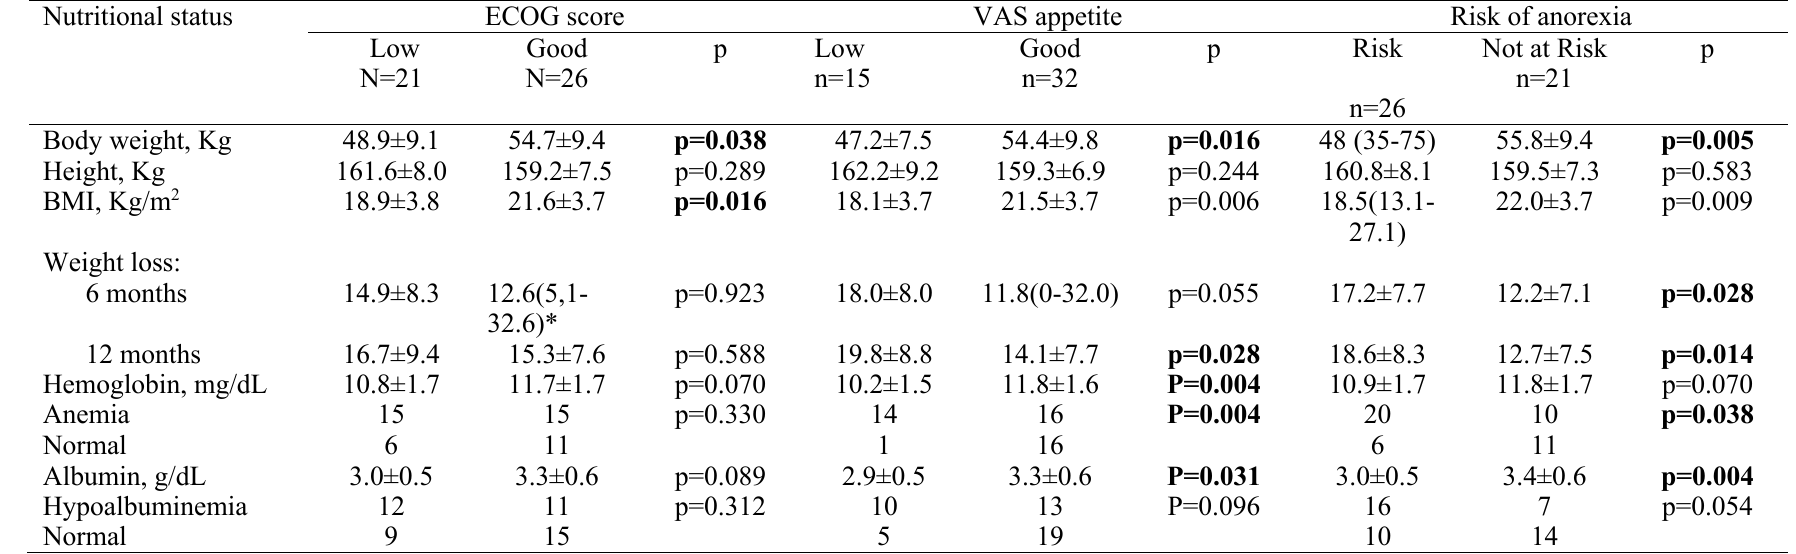
Table 2. Nutritional status related to ECOG score, VAS appetite and SNAQ score Nutritional